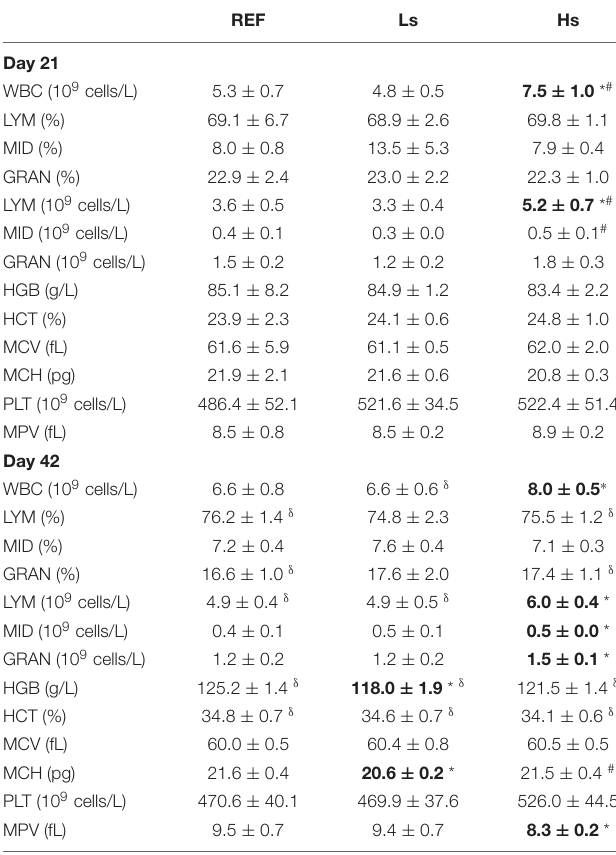
White Blood Cells (WBC), lymphocyte (LYM), monocytes, eosinophils, basophils, blasts, and other precursor white cells (MID), neutrophils, monocytes, eosinophils, and basophils (GRAN), hemoglobin (HGB), hematocrit (HCT), Mean Cell Volume (MCV), Mean Cell Hemoglobin (MCH), platelets (PLT) and Mean Platelet Volume (MPV). Results are expressed ad mean ± SEM (n = 10). Statistical significance: * p < 0.05 vs. REF and # p < 0.05 Hs vs. Ls and δ day 42 vs. day 21. REF, reference group; Ls, group supplemented with low dose of S. epidermidis and Hs, group supplemented with high dose of S. epidermidis. Bold values mean statistical difference with respect to REF